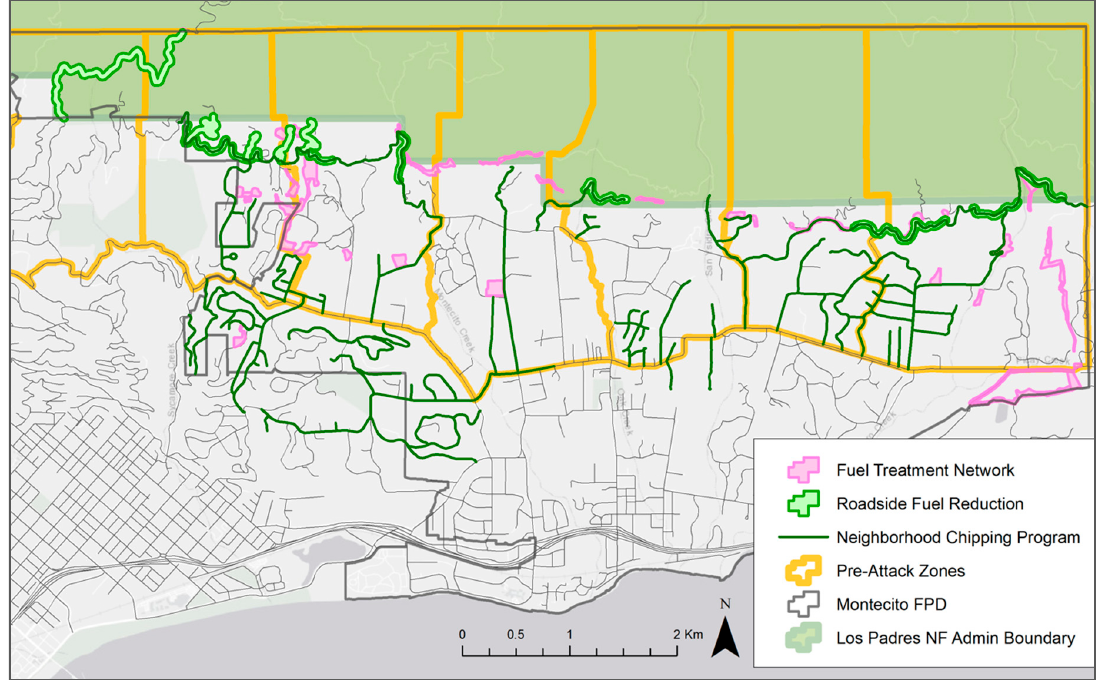
Figure 5. Location of different types of vulnerability reduction activities across the community of Montecito, including delineation of pre-attack zones used for evacuation planning, and fuel reduction treatments including Roadside fuel reduction efforts, the Neighborhood Chipping program, and the Fuel Treatment Network. (Adapted from [47]).